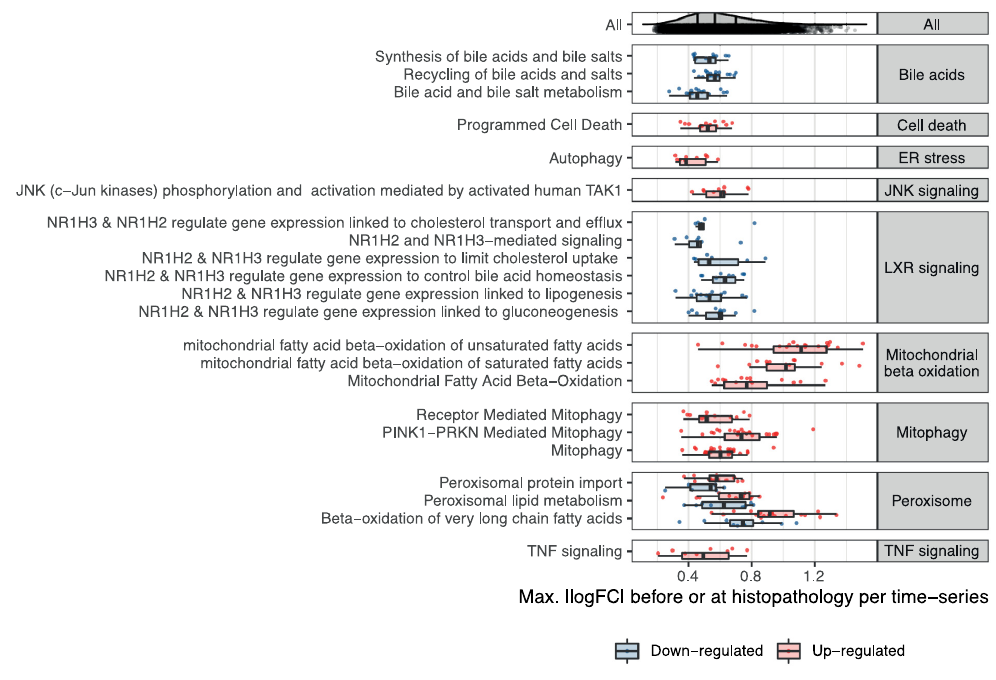
Fig 5. Observed max. |logFC| before adverse histopathology. For known processes in DILI which correspond to significantly enriched events before adverse histopathology, the max |logFC| before adverse histopathology is shown. In comparison to other known pathways and the overall background distribution, a high logFC is found for mitochondrial beta oxidation followed by peroxisomal beta oxidation and mitophagy.